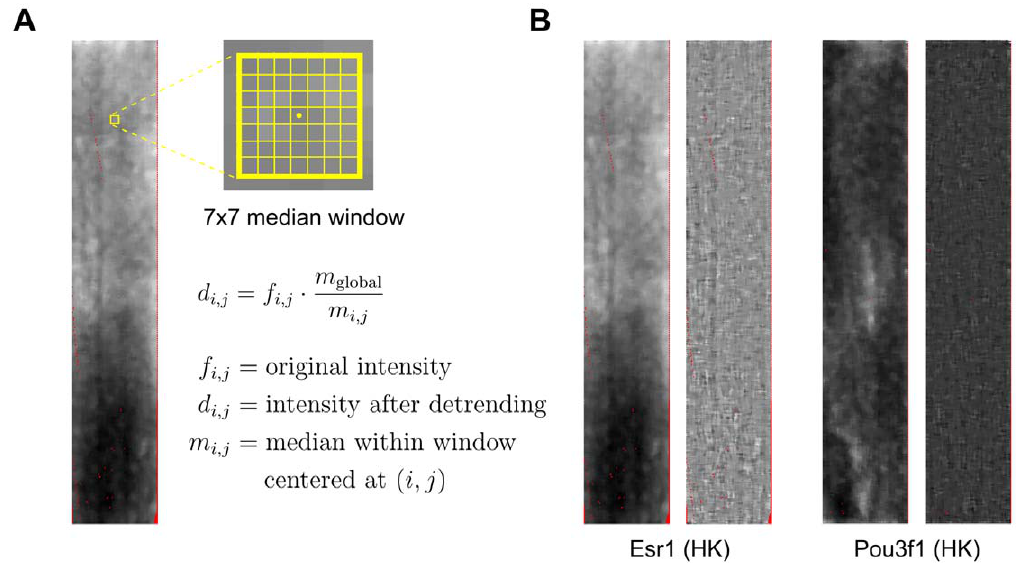
Figure 5. Spatial detrending. (a) A 7 6 7 median window is used to rescale probe intensities. (b) Two examples of how the spatial detrending step successfully removes large light and dark regions (spatial artifacts) in PBM samples. Original samples on the left, preprocessed samples on the right. Red pixels indicate missing or discarded intensity values.